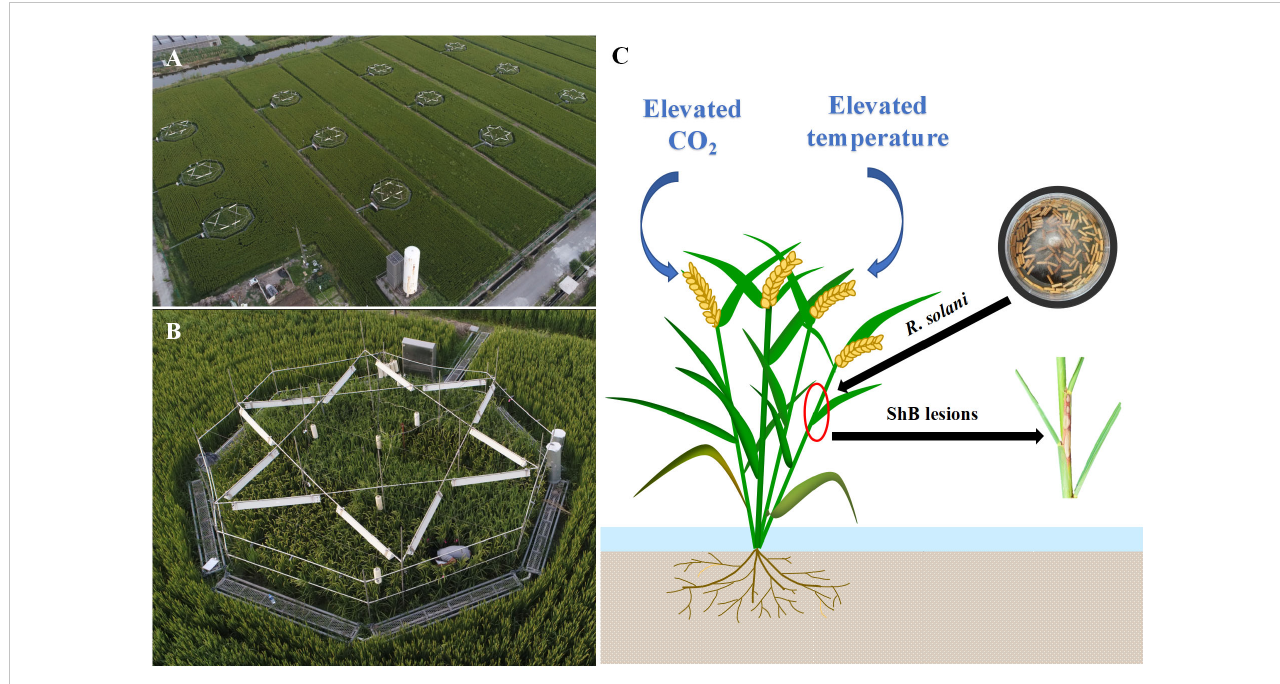
FIGURE 1 (A, B) In this T-FACE experiment, four treatments were designed with twelve octagonal plots: two CO 2 levels (ambient and enriched up to 590 m mol mol -1 ) and two temperature levels (ambient and increased by 2.0°C). Each treatment was set three repetitions. (C) For inoculation experiment, the inoculum with R. solani was placed 1 cm depth inside the third sheath from top, then plant was infected forming ShB